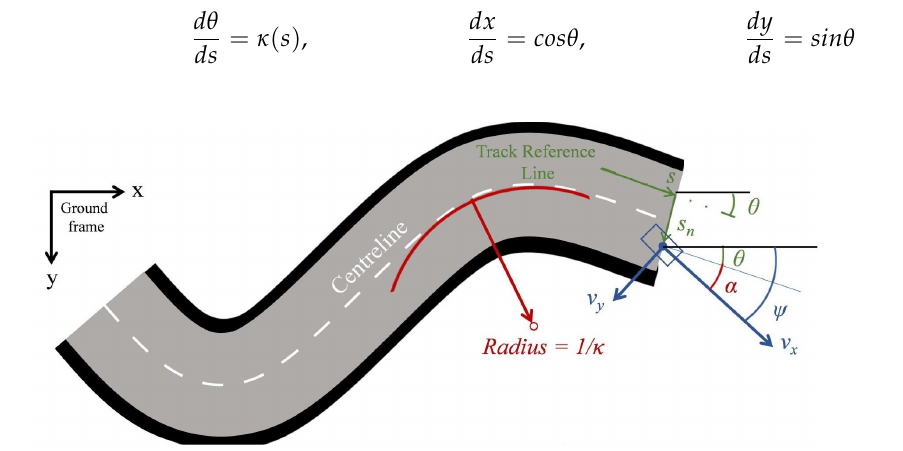
Figure 1. Curvilinear coordinates for road